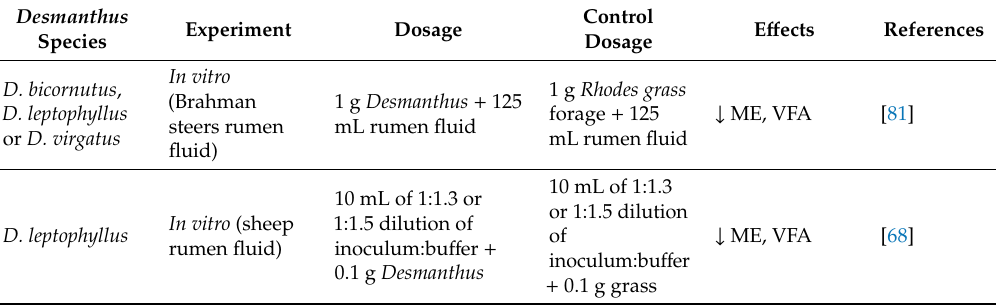
Table 2. E ff ects of Desmanthus on methane production, growth performance and rumen fermentation a